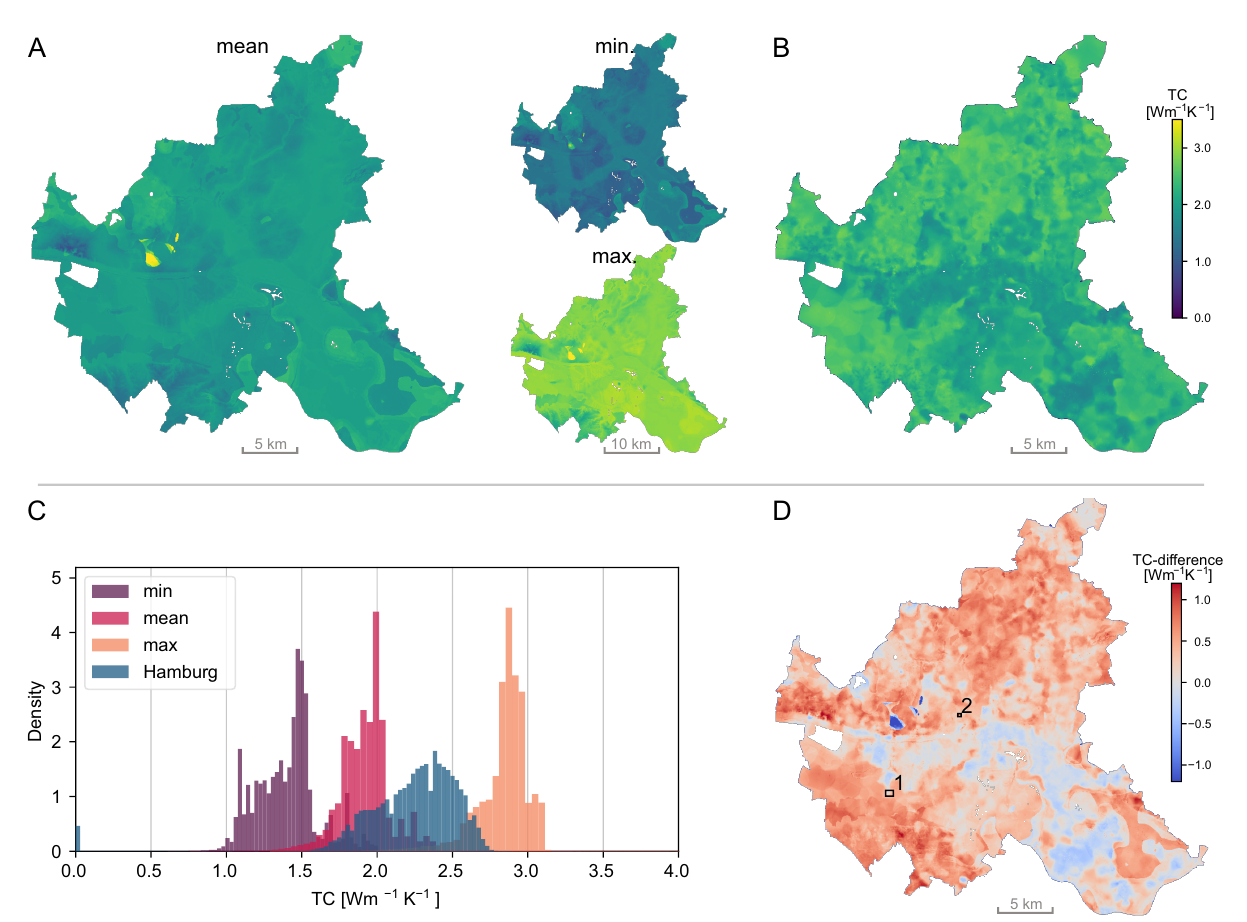
Figure 6. Thermal conductivity estimates for a BHE length of 100 m for the federal state of Hamburg. ( A ) result of the large-scale TC estimation, ( B ) TC map published by Hamburg, ( C ) histogram of TC values of the four maps, ( D ) difference between TC Hamburg and our mean estimate (TC ls-mean ) and location of target areas of the high-resolution